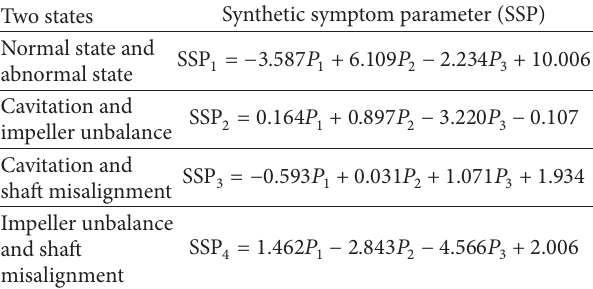
Table 3: Synthetic symptom parameters (SSPs) between two states.